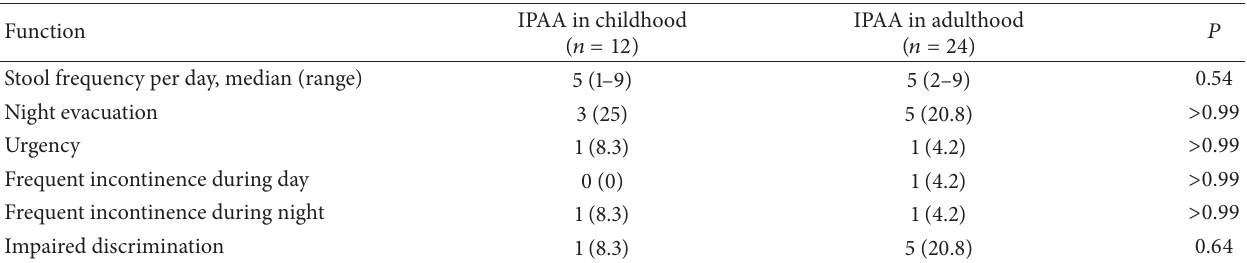
Table 2: Bowel function of IPAA patients by age. Except where indicated otherwise, data are n (%) values. Function